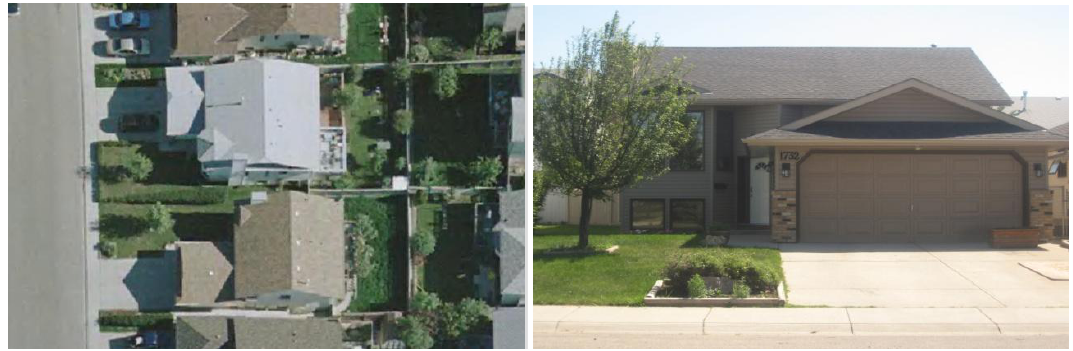
Figure 4. Residential House used for Data Collection.